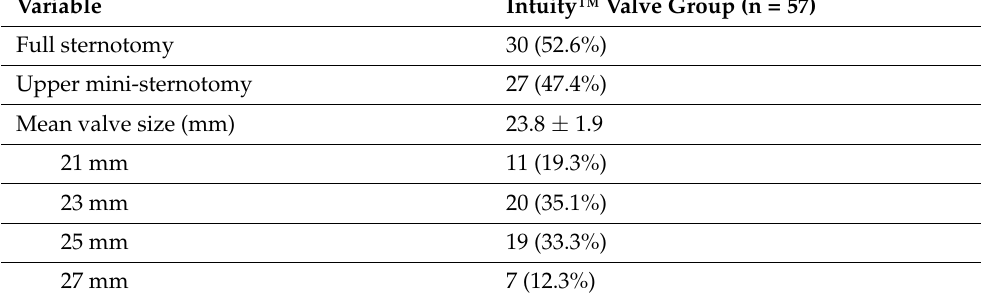
Table 2. Intraoperative